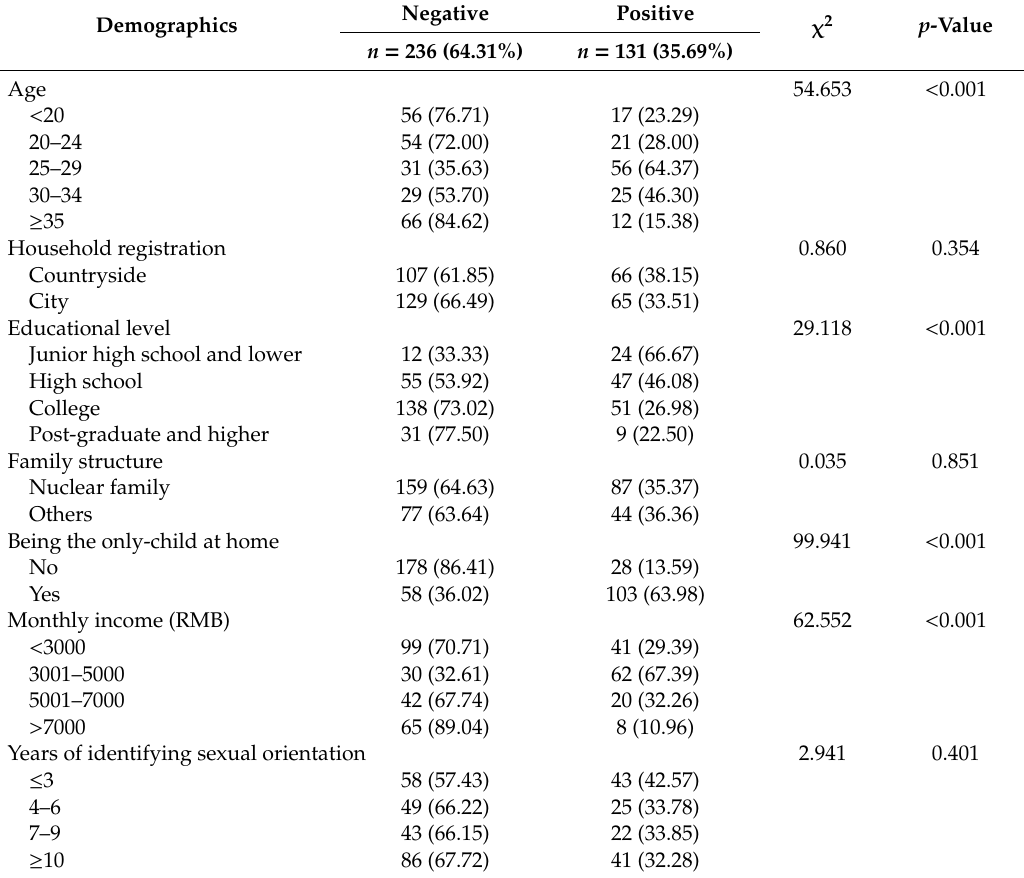
Table 1. Demographic information of participants by interpersonal sensitivity status ( n = 367). Demographics